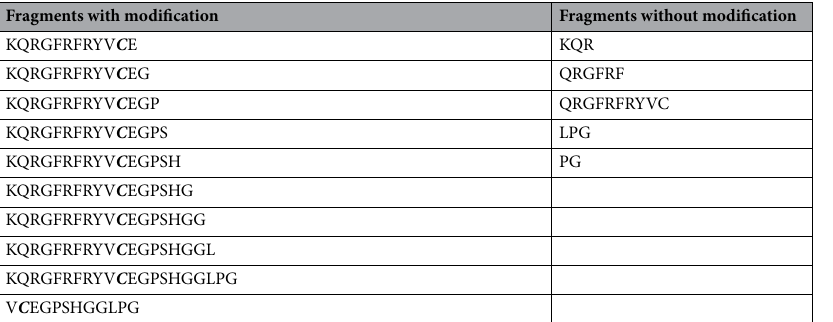
Fragments with modification Fragments without